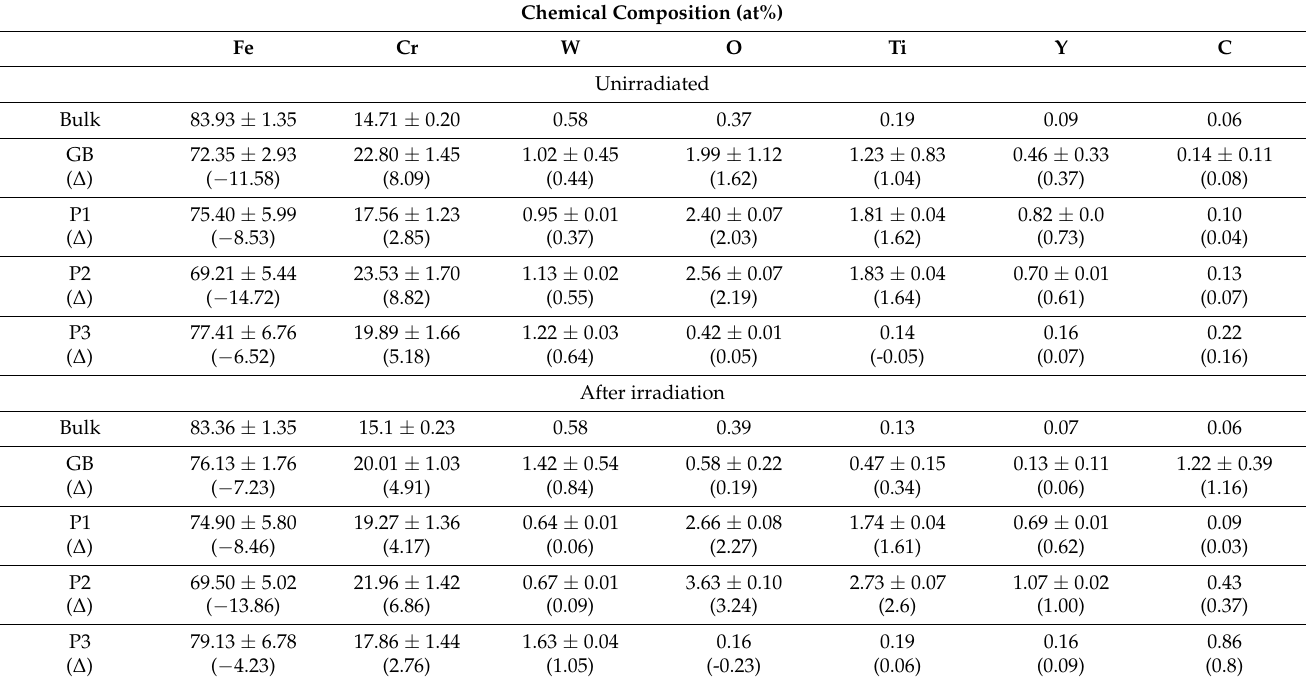
Figure 6. The three selected different positions in the 14YWT (( aP 1 , bP 1 ) is in the matrix containing a nano oxide particle; ( aP 2 , bP 2 ) crosses the grain boundary with a nano oxide particle; ( aP 3 , bP 3 ) crosses the grain boundary without the nano oxide particle; ( aP 1 ) is in the sample without heavy ion irradiation; ( bP 1 ) is in the sample with heavy ion irradiation) and their elements’ distributions (at%) along the volume in the 14YWT alloy ( a ) before heavy ion irradiation and ( b ) after heavy ion irradiation up to 100 dpa at 700 °C. Table 1. Average measured composition of bulk, grain boundary, and particles in the position P 1 , P 2, and P 3 referred to in Figure 6.